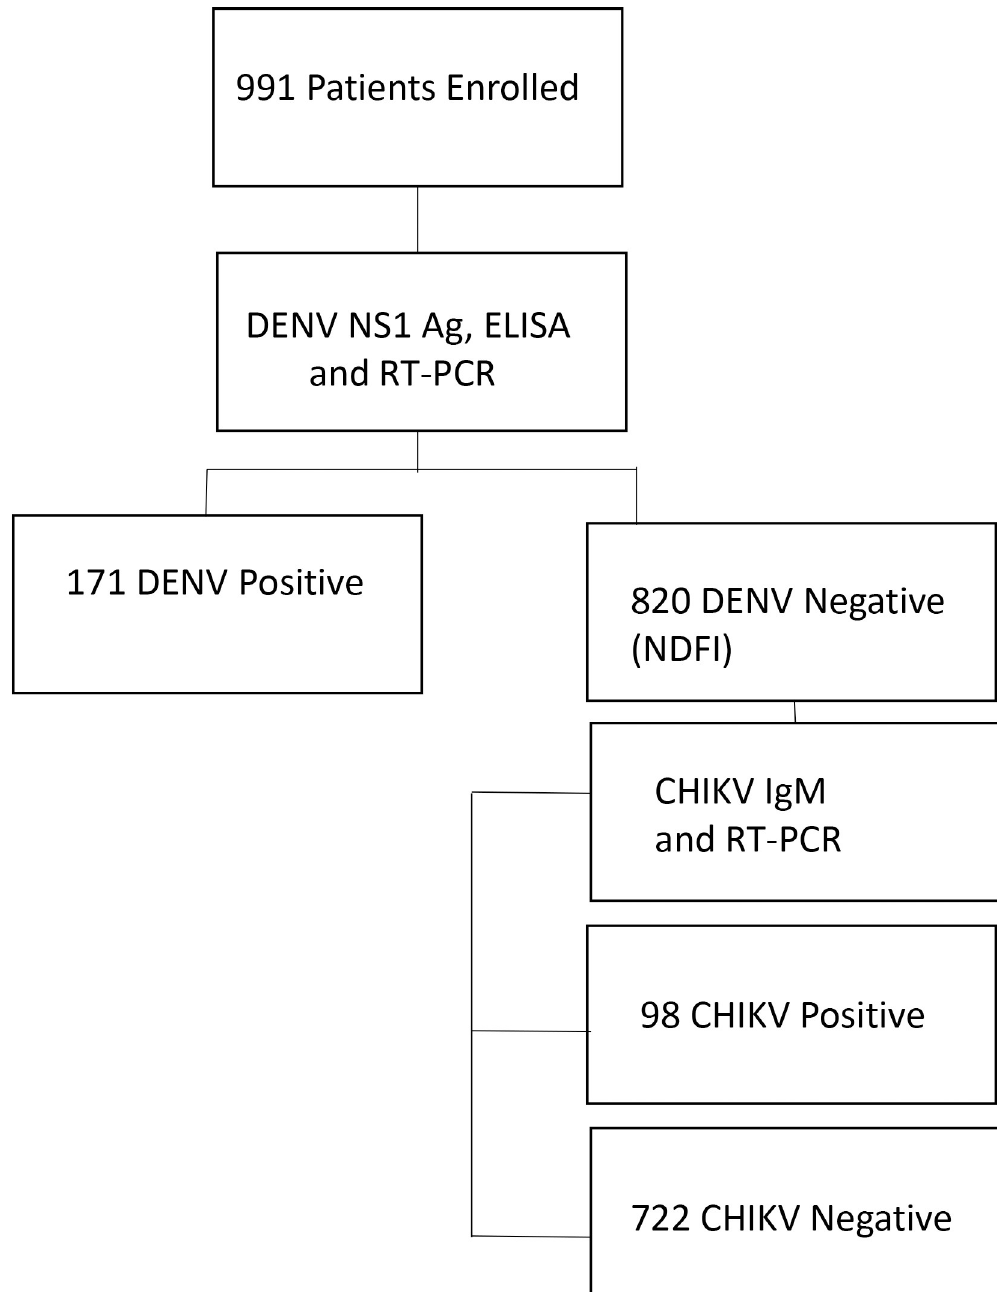
Fig 1. The diagnostic algorithm for DENV and CHIKV serologic testing. Flow chart illustrating patient recruitment according to inclusion criteria and workflow of specimen for DENV and CHIKV detection.